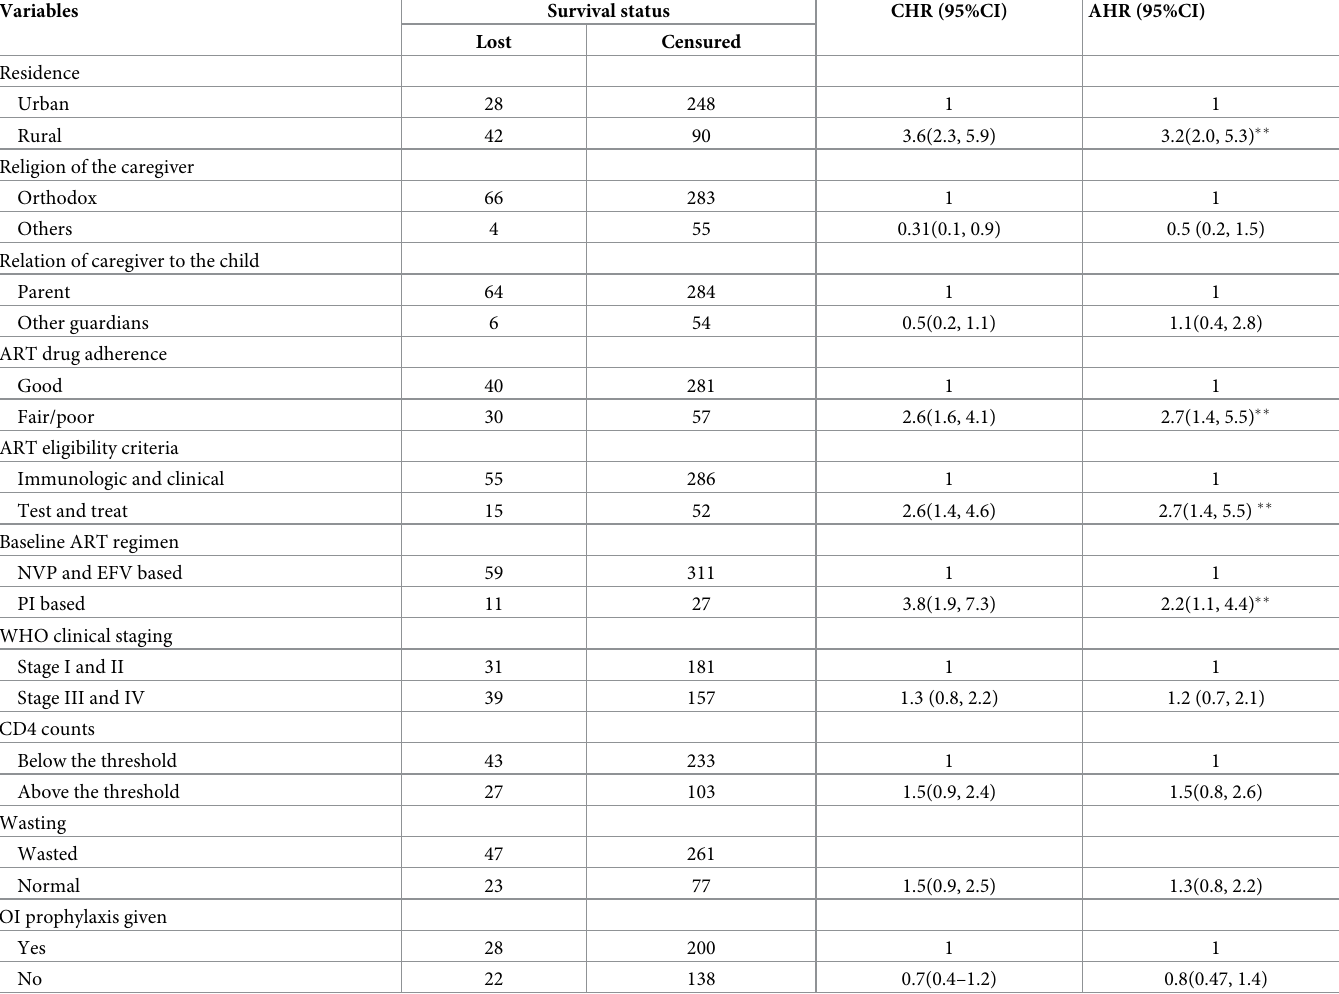
Table 3. Bi-variable and multivariable Cox regression analysis to identify the predictors of LTFU among HIV-infected children receiving ART at Debre-Markos Referral Hospital, Northwest Ethiopia,